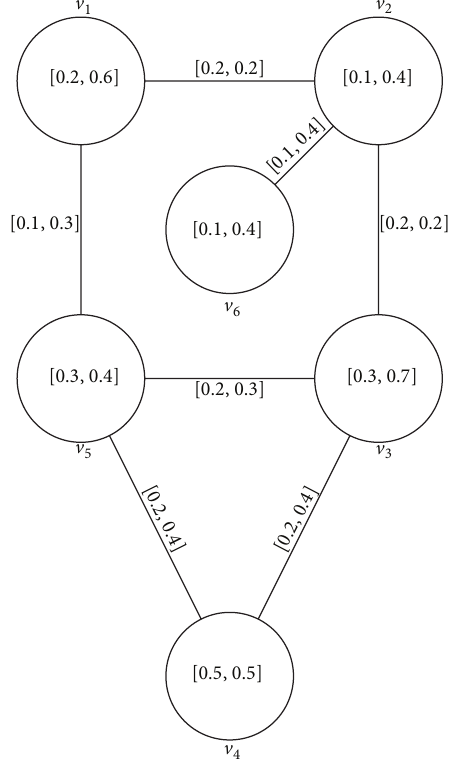
Figure 6: 𝐺 is highly